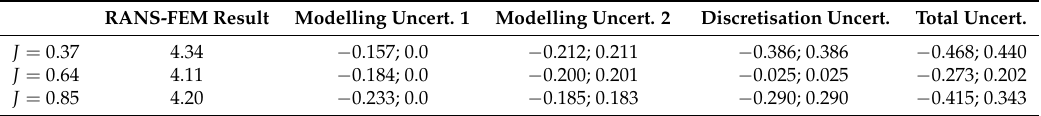
Table 8. Uncertainties (lower and upper levels) in mid-chord bend deformation at the tip in (mm).